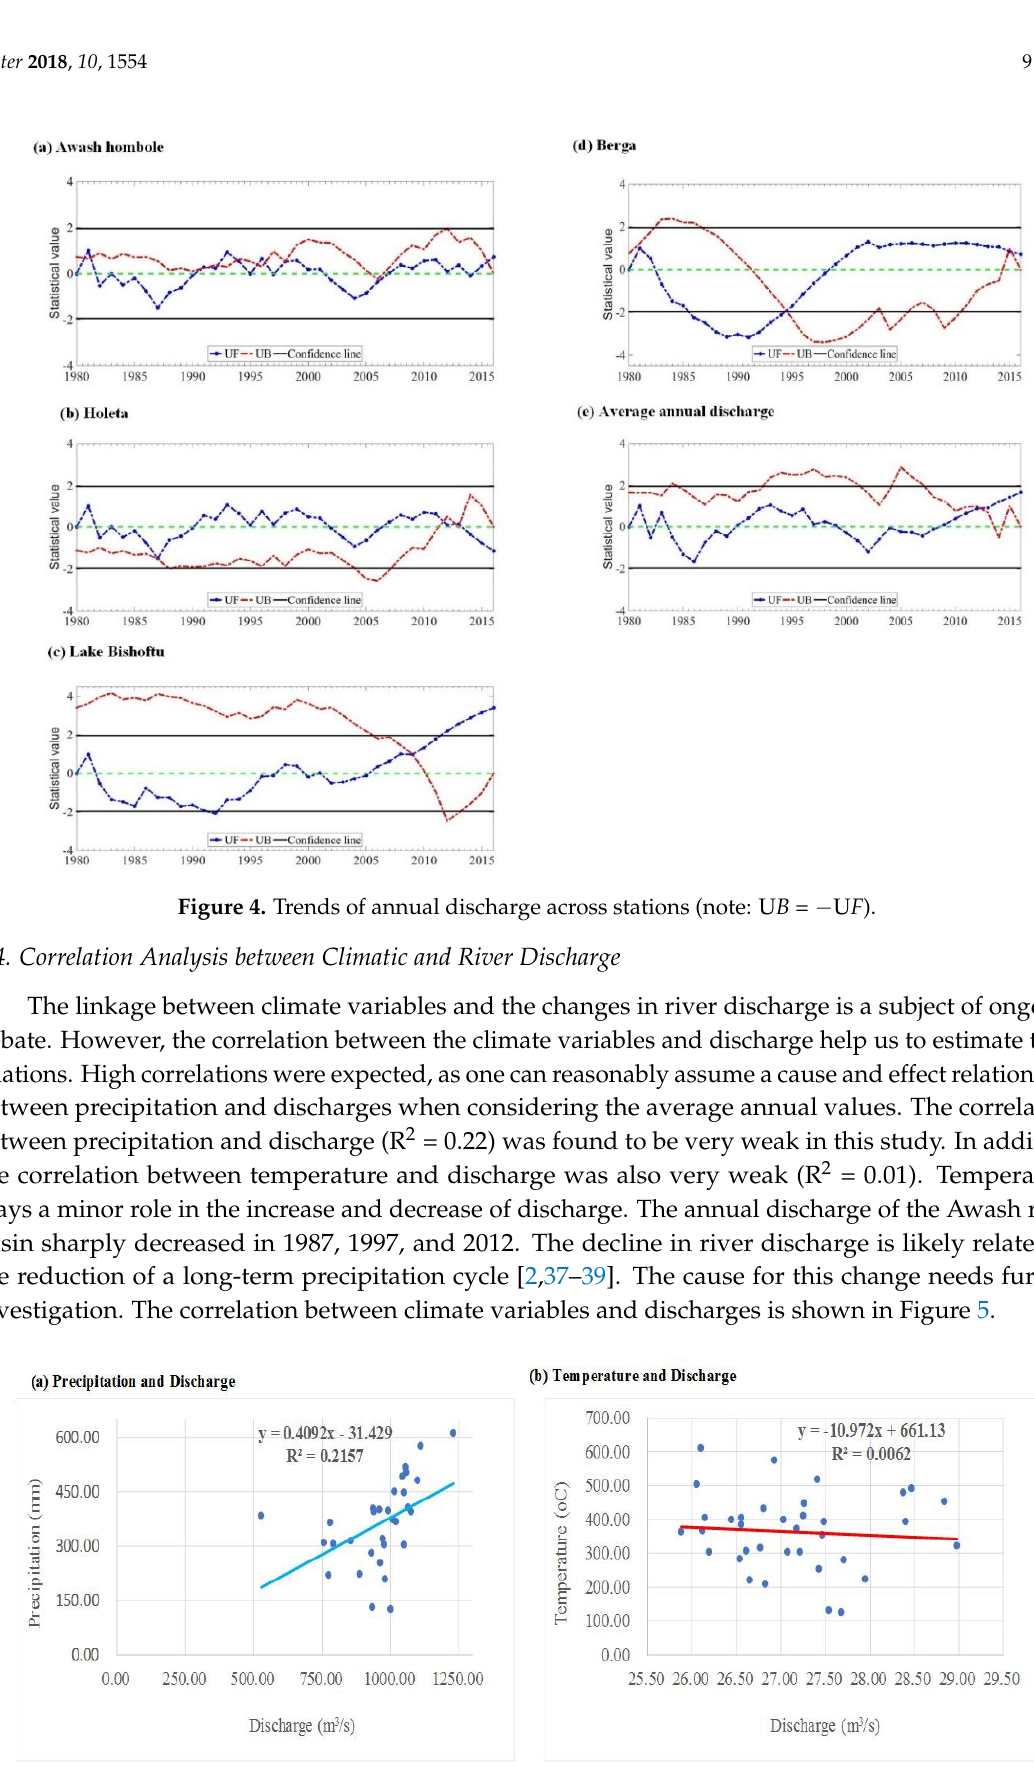
Figure 5. Correlation coefficient between ( a ) precipitation and discharge; ( b ) temperature and discharge.